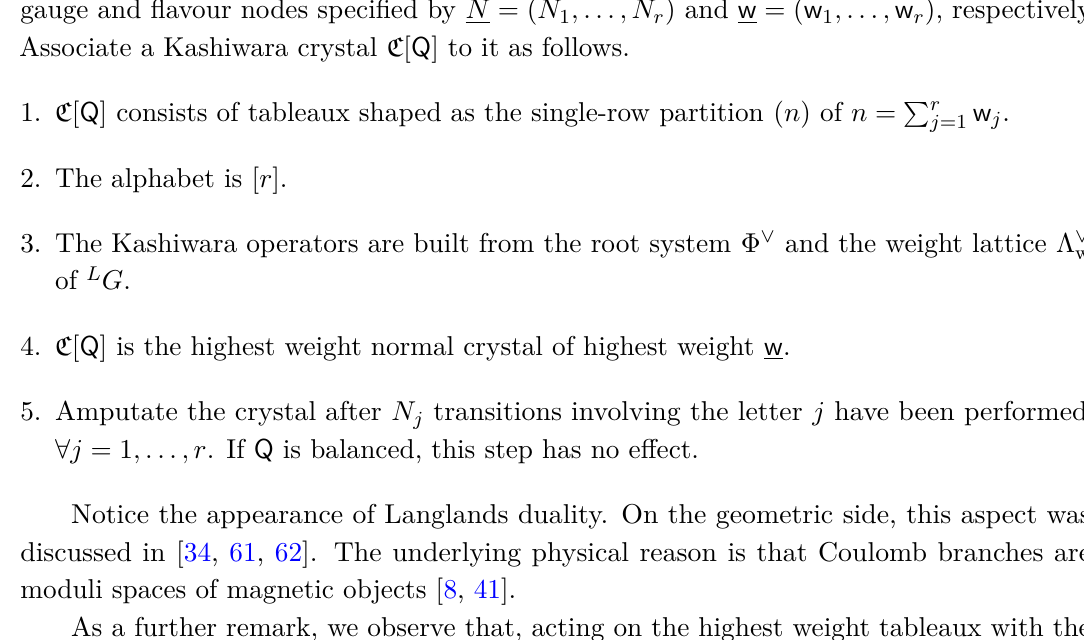
) and w = ( w ) , respectively. , . . . , N , . . . , w 1 r 1 r